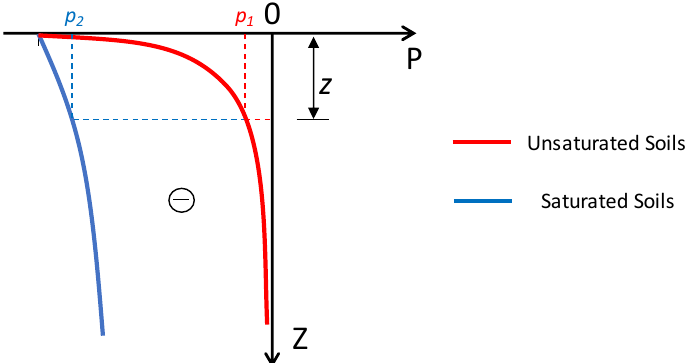
Figure 3. Typical pore pressure distributions in saturated and unsaturated soils during the passage of a wave trough (modified from [58]).